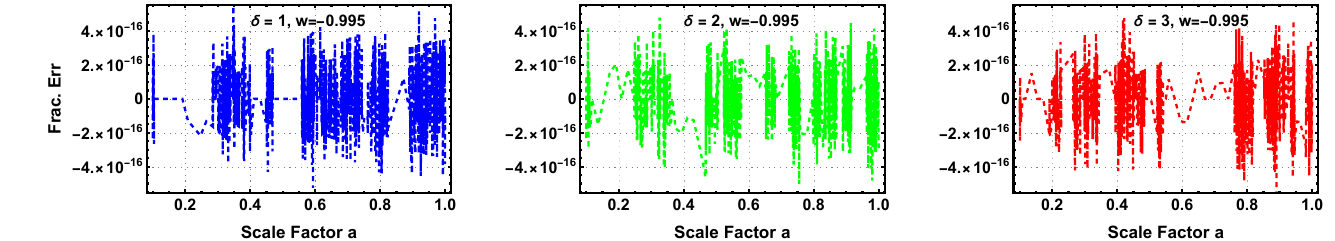
Figure 13. The fractional error for the first Friedmann constraint with w = − 0.995 and δ = 1, 2, and 3.